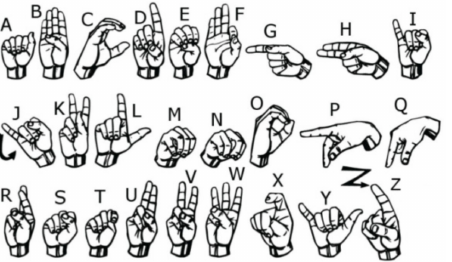
Figure 1. Twenty-six letters in ASL alphabet with different patterns of fingers and hand